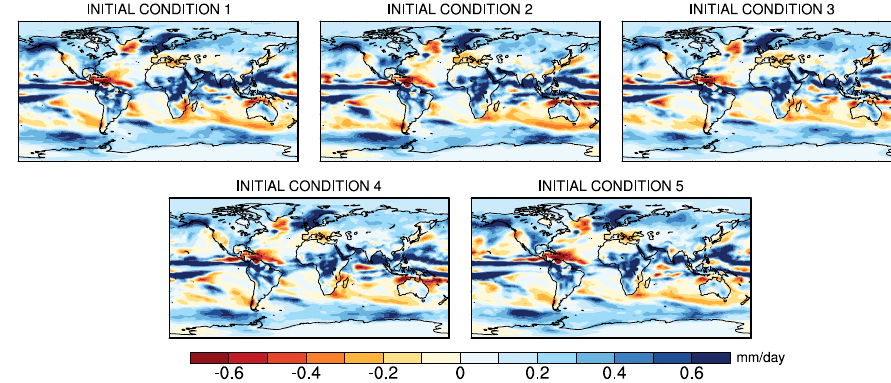
Fig. 18. Same as Fig. 16 but for changes in precipitation (mmday − 1